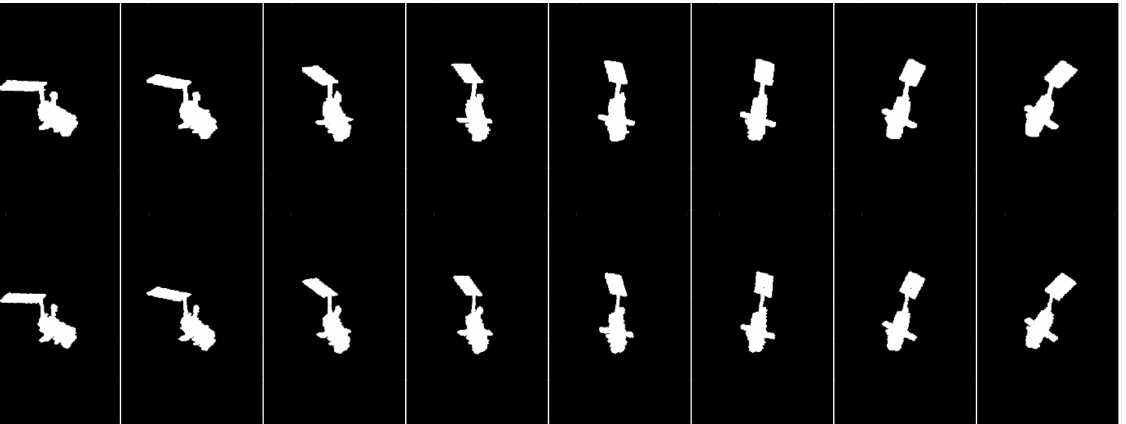
Figure 12. Comparisons between the ISAR image sequence and the projection image sequence of SRST. The first row is part of the simulated ISAR image sequence and the second row is the corresponding result of the projection image sequence.